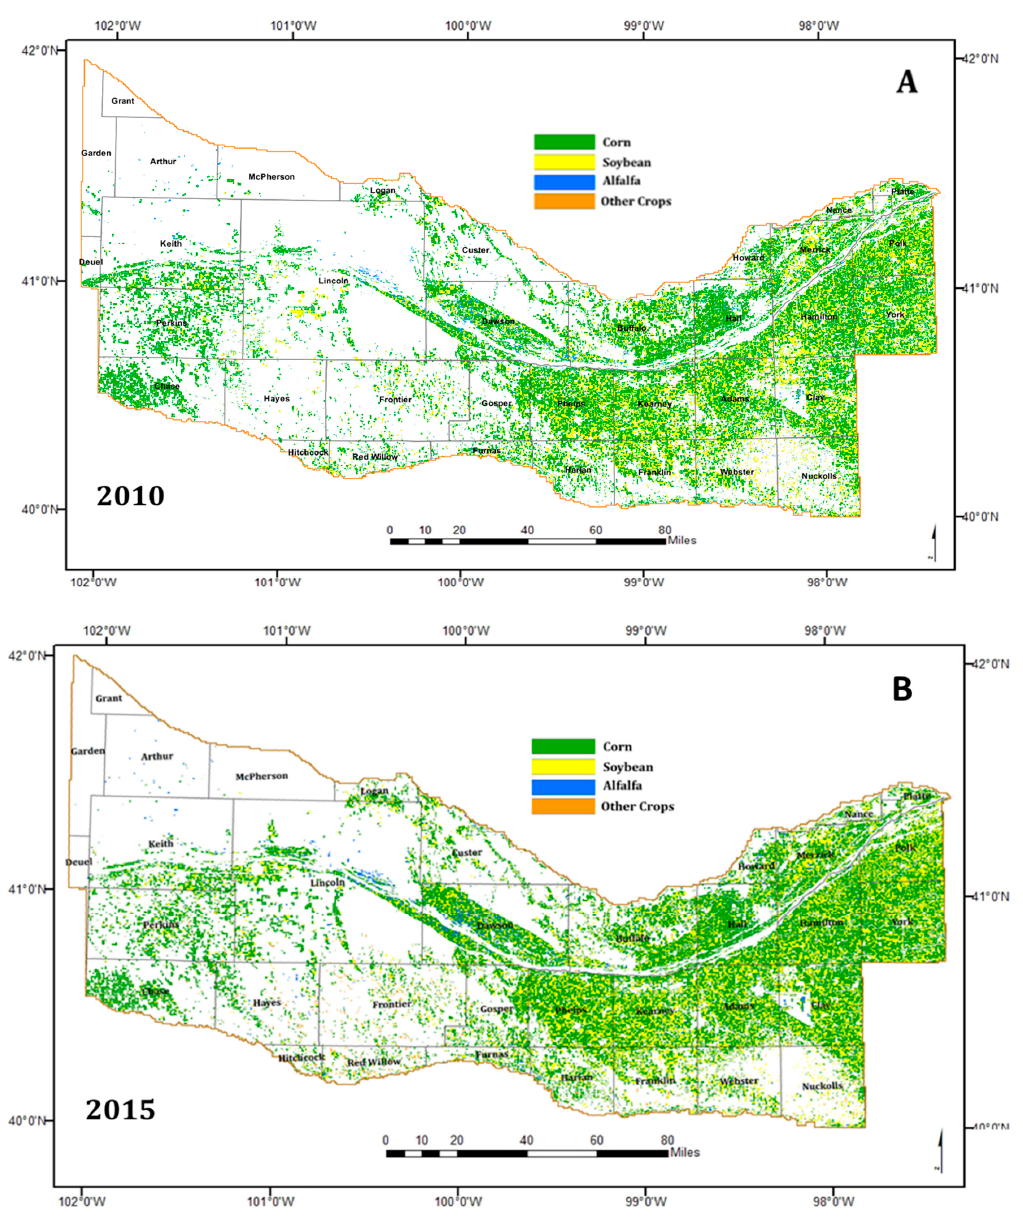
Figure 7. Spatial distribution of NEG derived irrigated fields in the COHYST model region during the growing season of 2010 ( A ) and 2015 ( B ). Crop types derived from NASS